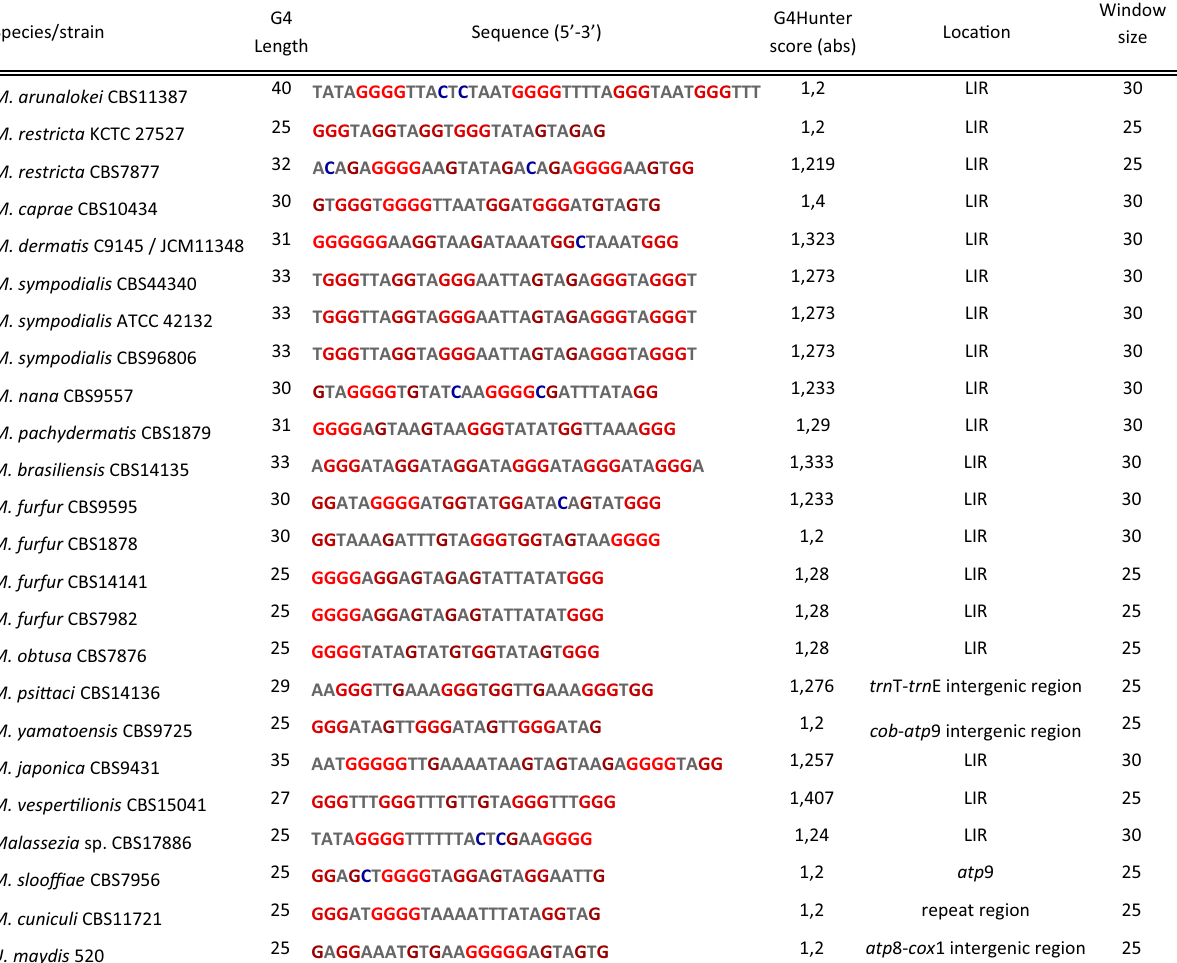
Table 2. Predicted G4s with the highest score in G4hunter tool for each Malassezia species. G4 length, sequence, score and location on the mitogenome is provided. G4 residues are colored based on their contribution to the final score, i.e., dATPs and dTTPs are neutral (black color), dGTPs are positive (red color) and dCTPs negative (blue color). The window size, in which the best G4 was predicted, is also indicated. M. globosa and M. equina are not included since the score of the predicted G4s did not exceed